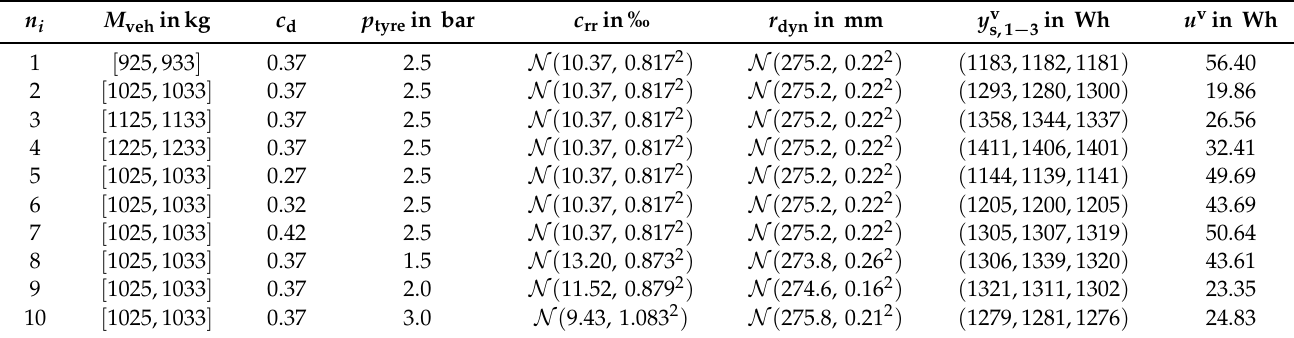
Table 2. Validation model uncertainty learning data set with the variation of 10 linear combinations of the